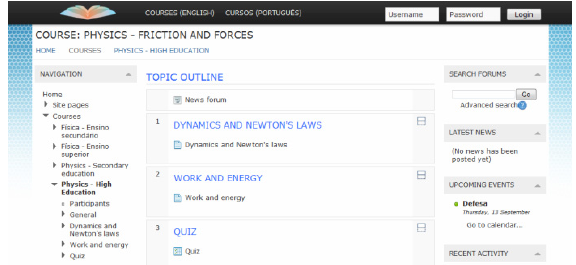
Figure 2. Example of a course’s interface at flock.uc.pt web